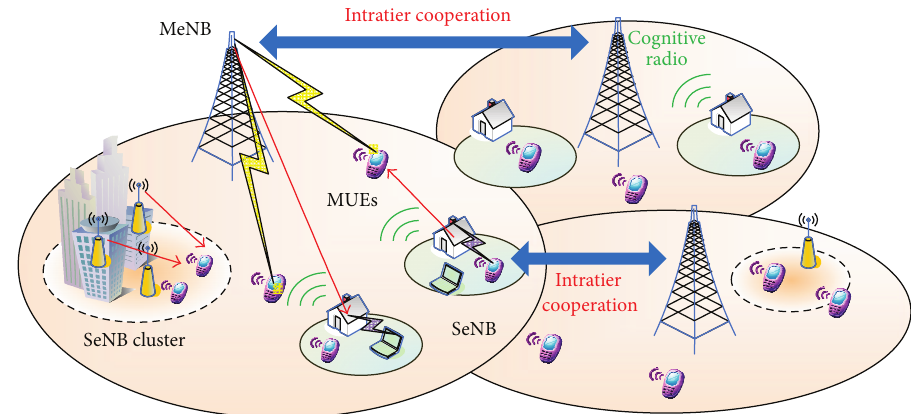
Figure 1: Transmission in multiple access relay channels.